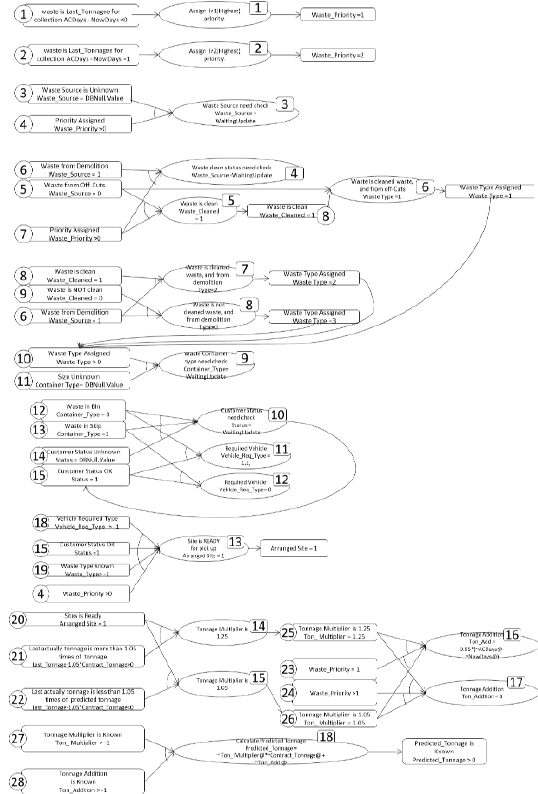
Fig. 5. Reasoning Chain of Generation the Schedule (First